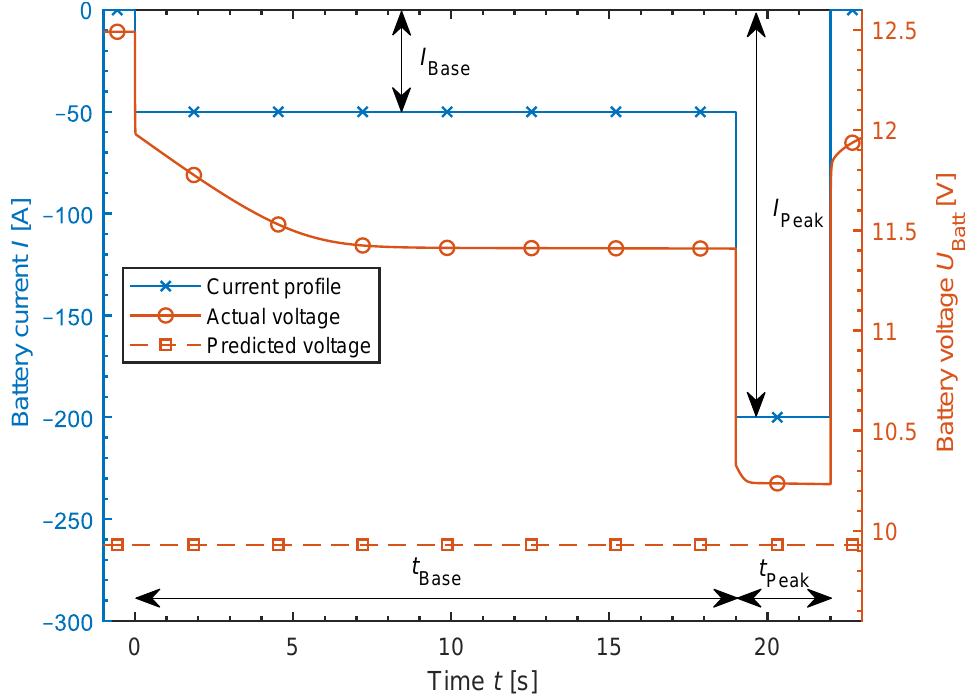
Figure 5. Comparison of minimum predicted battery voltage U min,pred,Batt = 9.93V calculated by the battery diagnostics using a predefined current profile versus minimum actual battery voltage U min,act,Batt = 10.23V of a battery